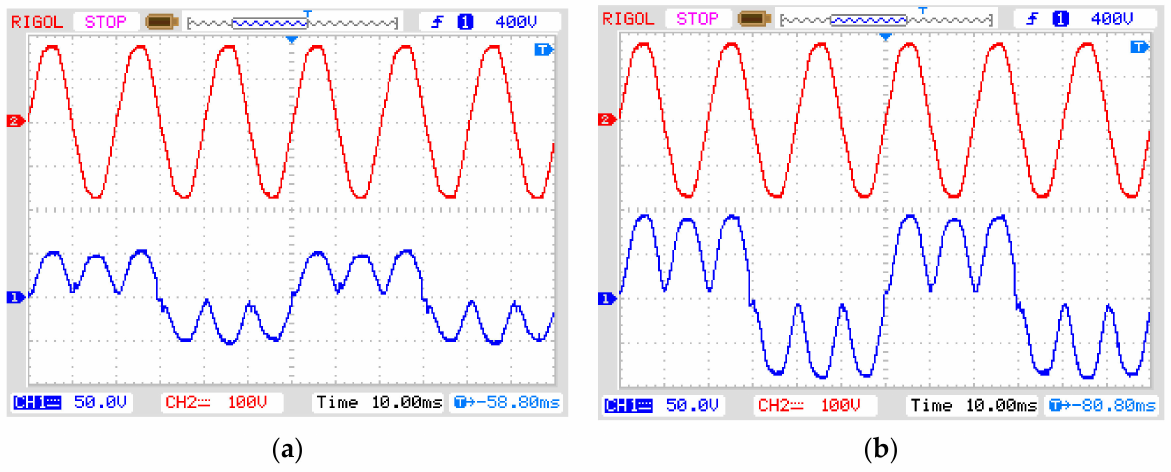
Figure 11. Real value results for output frequency step-down process with a voltage gain of ( a ) 0.3 and ( b ) 0.55.